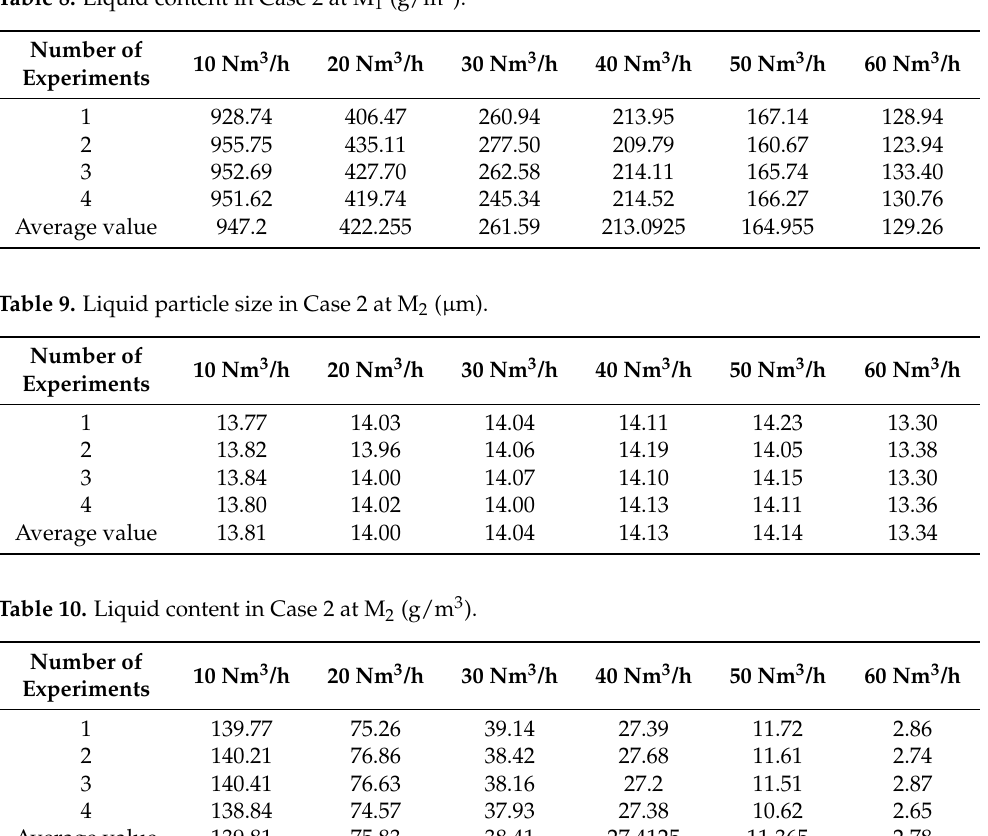
Table 8. Liquid content in Case 2 at M 1 (g/m 3 ).